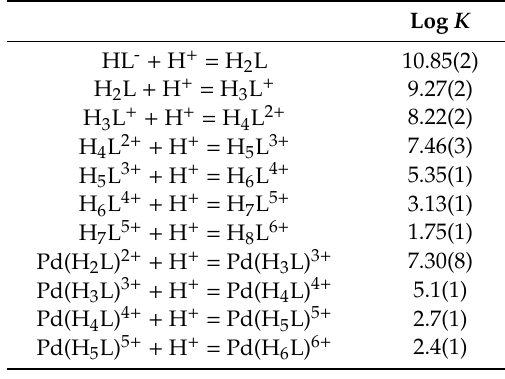
Table 1. Protonation constants of the H 2 L ligand and of its Pd 2 + complex determined in 0.15 M NaCl aqueous solutions at 298.1 ±